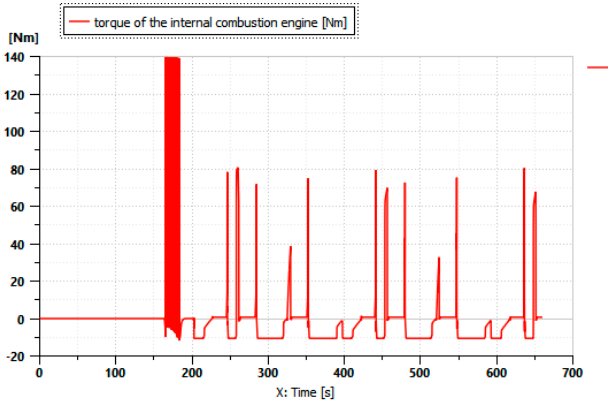
Figure 6. Thermal engine torque.